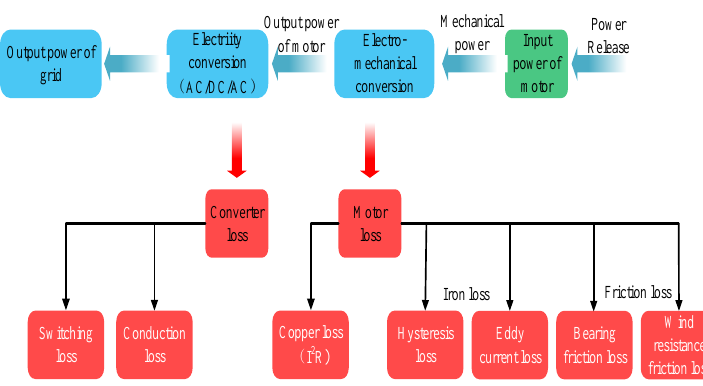
Figure 2. Energy conversion during flywheel discharge.